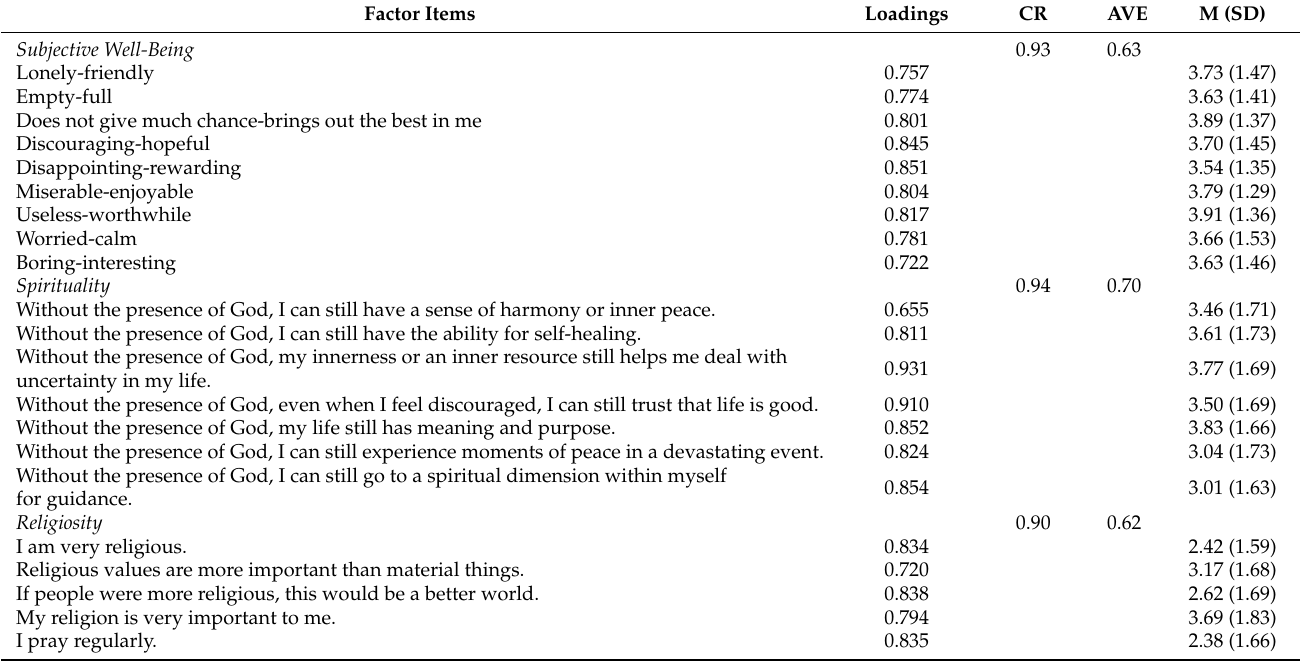
Table 1. Confirmatory factor